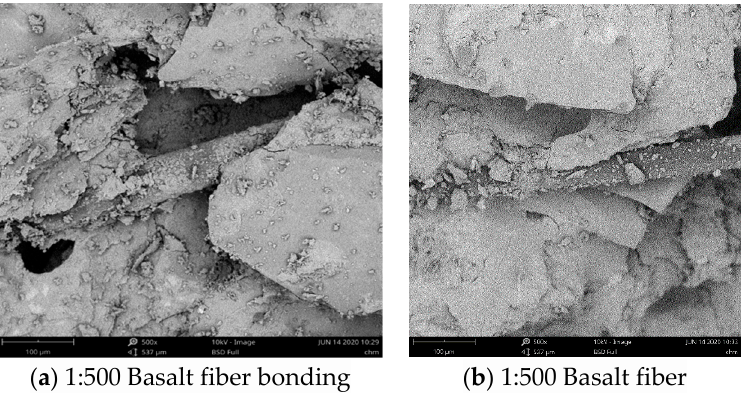
Figure 6. SEM of basalt fiber mortar.